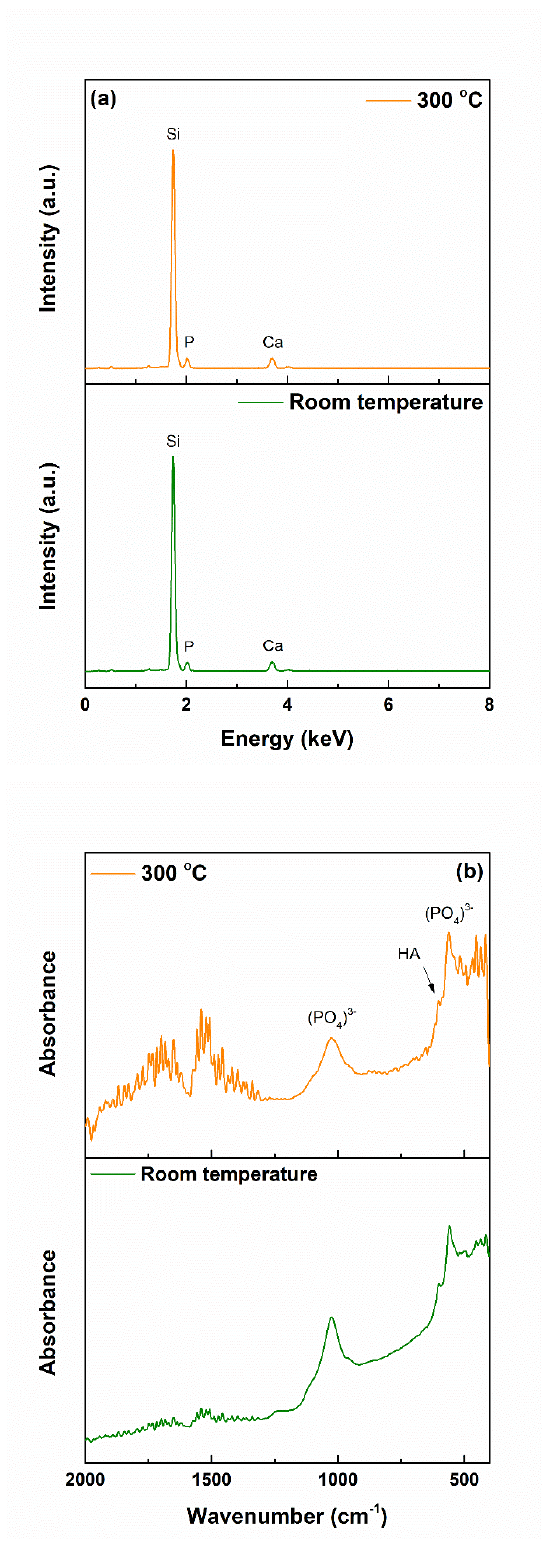
Figure 7. ( a ) EDX spectra and ( b ) FTIR spectra of the coatings, after immersion in SBF for 28 days.